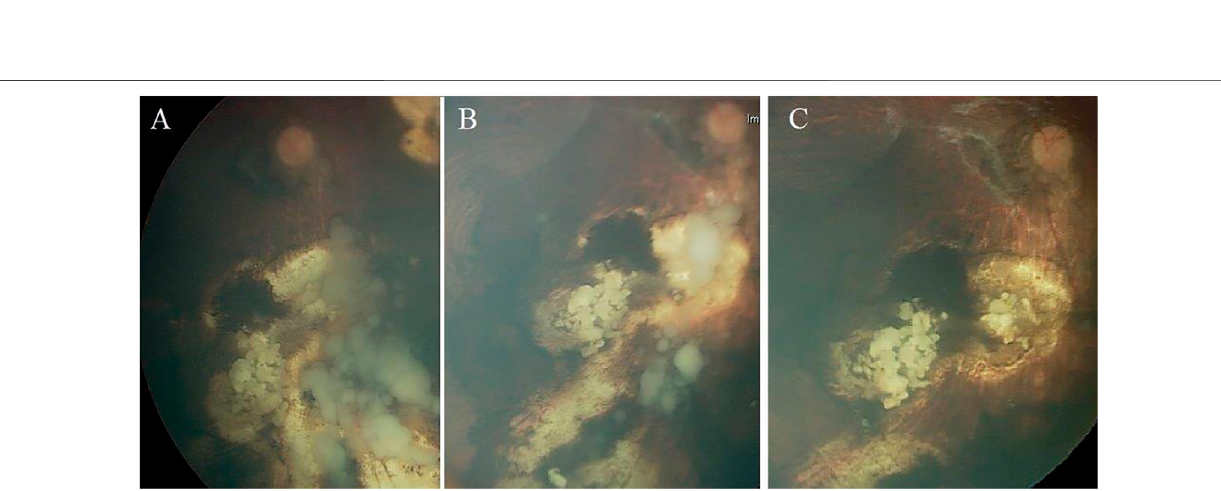
Frontiers in Pharmacology |